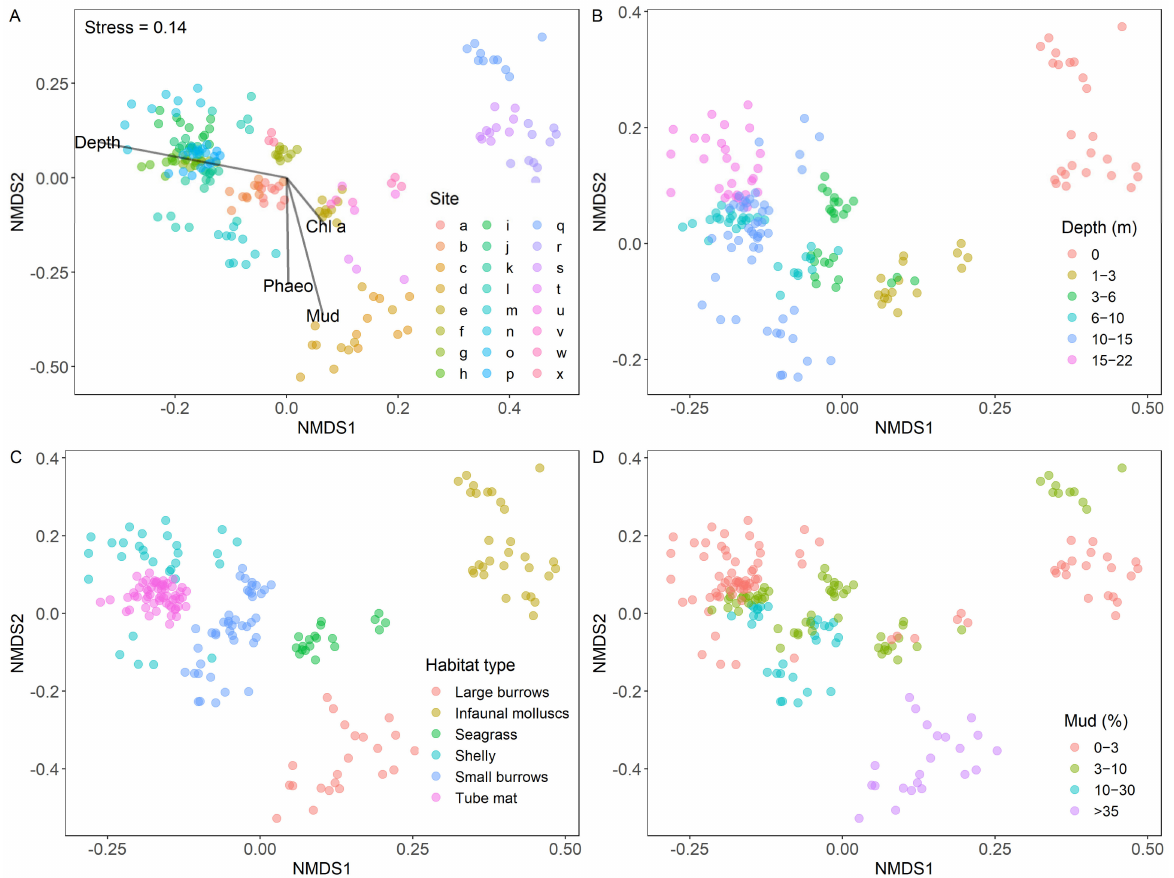
Figure 2. Non-metric multidimensional scaling (nMDS) plot of the macrofauna community as a function of ( A ) site, ( B ) water column depth, ( C ) habitat type and ( D ) sediment mud